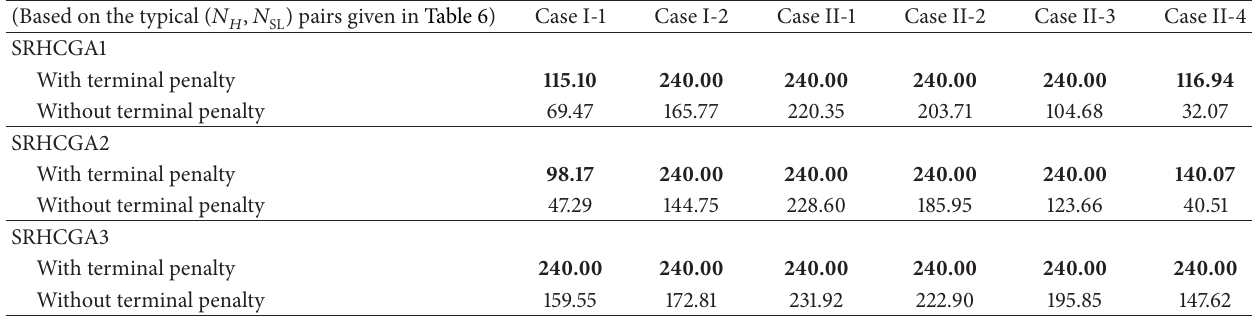
Table 7: The importance of terminal penalty in objective function for SRHCGAs.